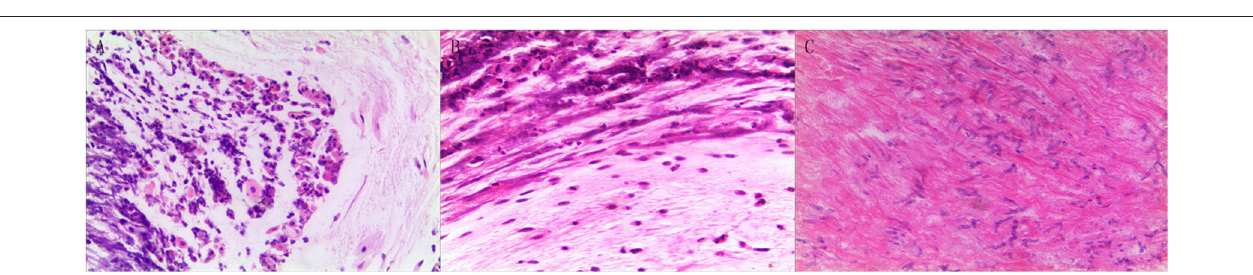
FIGURE 3 | Pathologic results of tracheal biopsy for the three cases. (A) Case 1 exhibited neutrophil infiltration and fibrinoid necrosis. (B) Case 2, it showed fibrinoid necrosis and purulent cells. (C) Case 3 demonstrated fibrinoid exudation and substantial Aspergillus load. (Hematoxylin and eosin staining, 200 ×